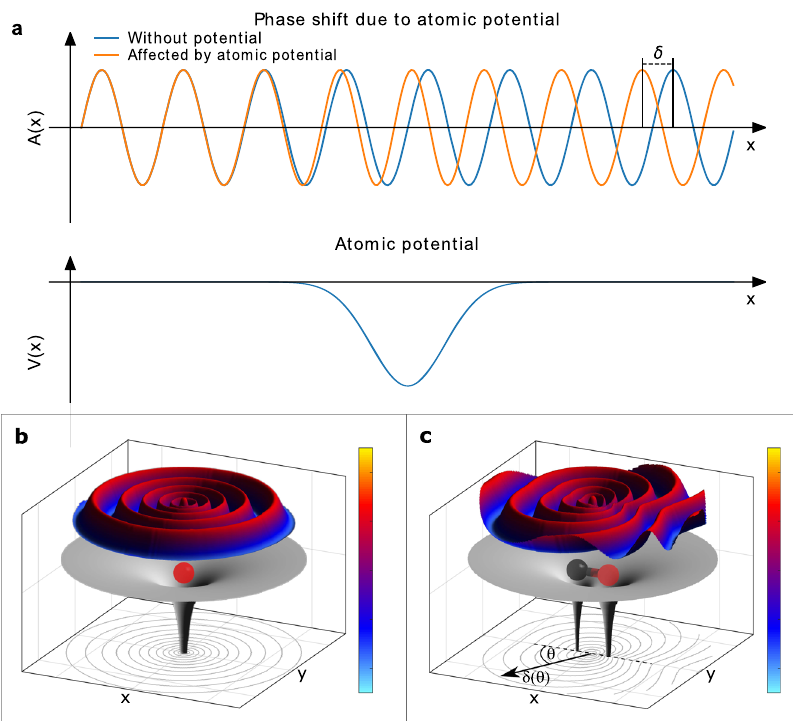
Fig. 1 Concept of the Wigner phase. a A plane wave with amplitude A ( x ) passes a potential V ( x ) from left to right. After passage, it acquires an additional phase δ due to the modulation of its wavelength by the potential. b Illustration of an electron wave emitted from within a single atomic potential. c The same as b but with an additional neighbouring atom resulting in a more complex molecular potential. The photoelectron wave is subject to a phase shift, which depends (due to the anisotropy of the potential) on the emission direction with respect to the molecular axis (e.g., δ O ≠ δ C , or more generally δ depends on the emission angle with respect to the molecular axis θ ). The sketch depicts as an example the two-well potential of a carbon monoxide